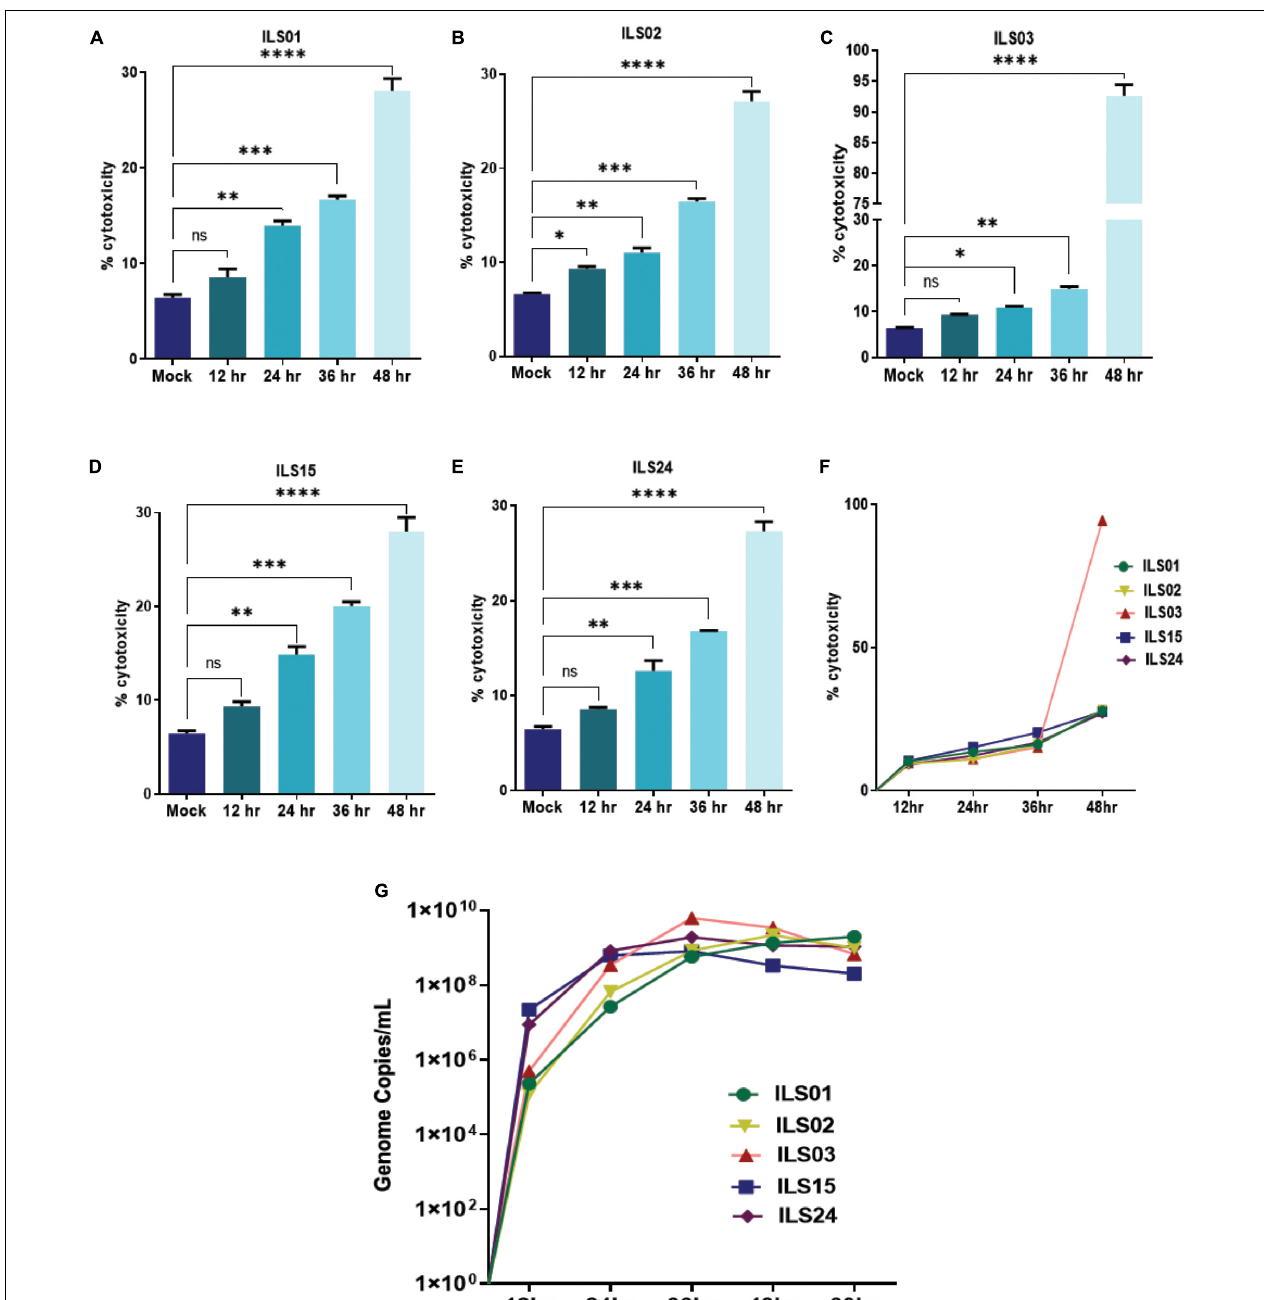
FIGURE 3 | Viral growth kinetics and cytopathy. Infection-associated cytopathy was determined by calculating LDH release, as described in the “Materials and Methods” section. (A–E) Graph depicting the percentage of cytotoxicity in the infected Vero E6 cells at respective time points post-infection. (F) Line plot depicting% cytotoxicity in between the isolation. (G) Line plot showing a time-dependent increase in the viral genome copies in culture supernatants determined by absolute quantification of the viral genome. Data are the mean value ± SD ( n = 3). Statistical significance was determined using one-way ANOVA; * P < 0.05; ** P < 0.01; *** P < 0.001; **** P < 0.0001 ns, not significant ( P > 0.05).